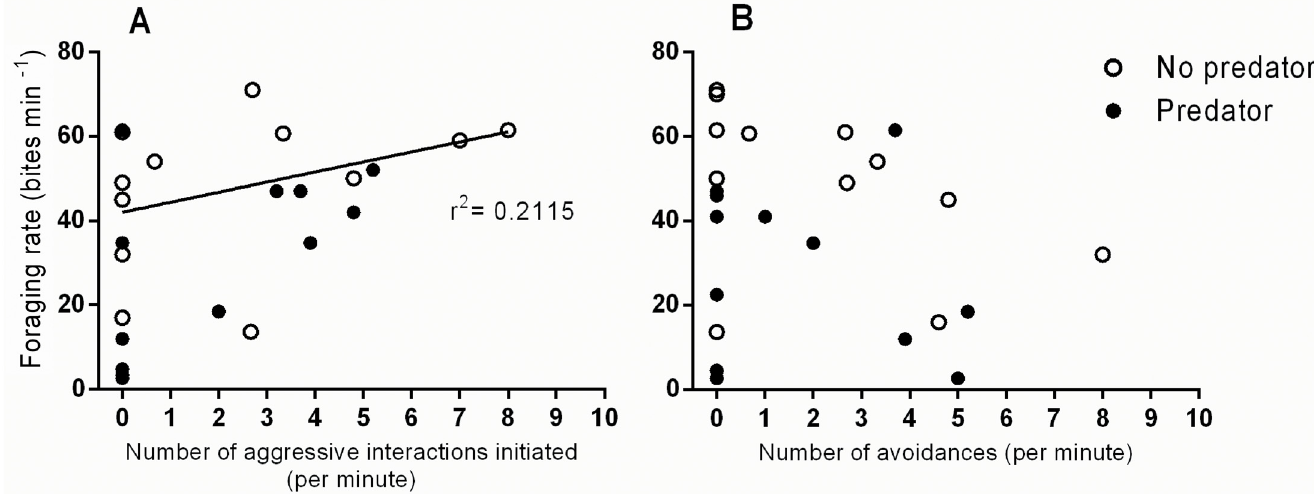
Fig 7. Relationship between foraging rates and A) the number of aggressive interactions (i.e. chases) initiated, and B) the number of avoidances (i.e. retreats) displayed for P . amboinensis and P . moluccensis (species pooled) in predator and no predator treatment. Line of fit on panel A represents that the slope is significantly different from